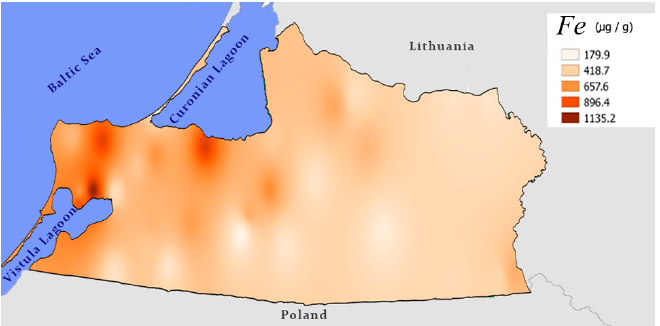
Figure 2. Distribution of iron in the thalli of H. physodes in the Kaliningrad region, 2010. Nickel concentrations are estimated at hundreds or even thousands of mass units, depending nickel accumulation [25]. The concentrations of nickel in the Kaliningrad region varied from 0.013 to